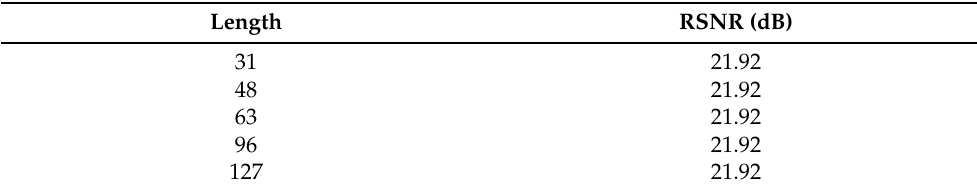
Table 3. Data extension length and RSNR( f 0 = 1590 Hz, N =